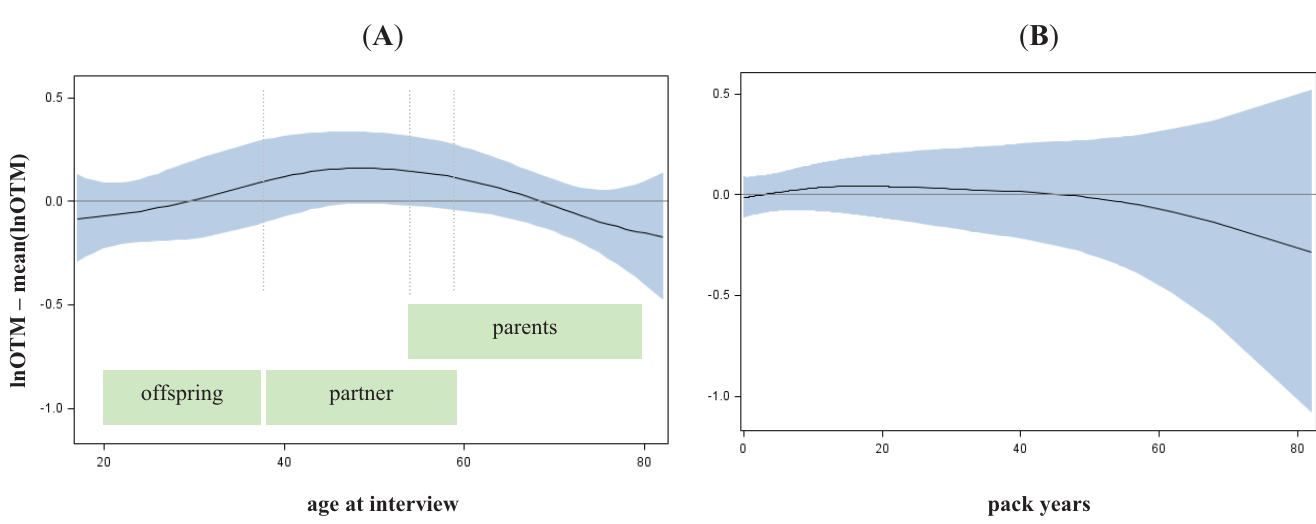
Legend to Figure 2: Lung cancer patients were disregarded to avoid bias due to disease